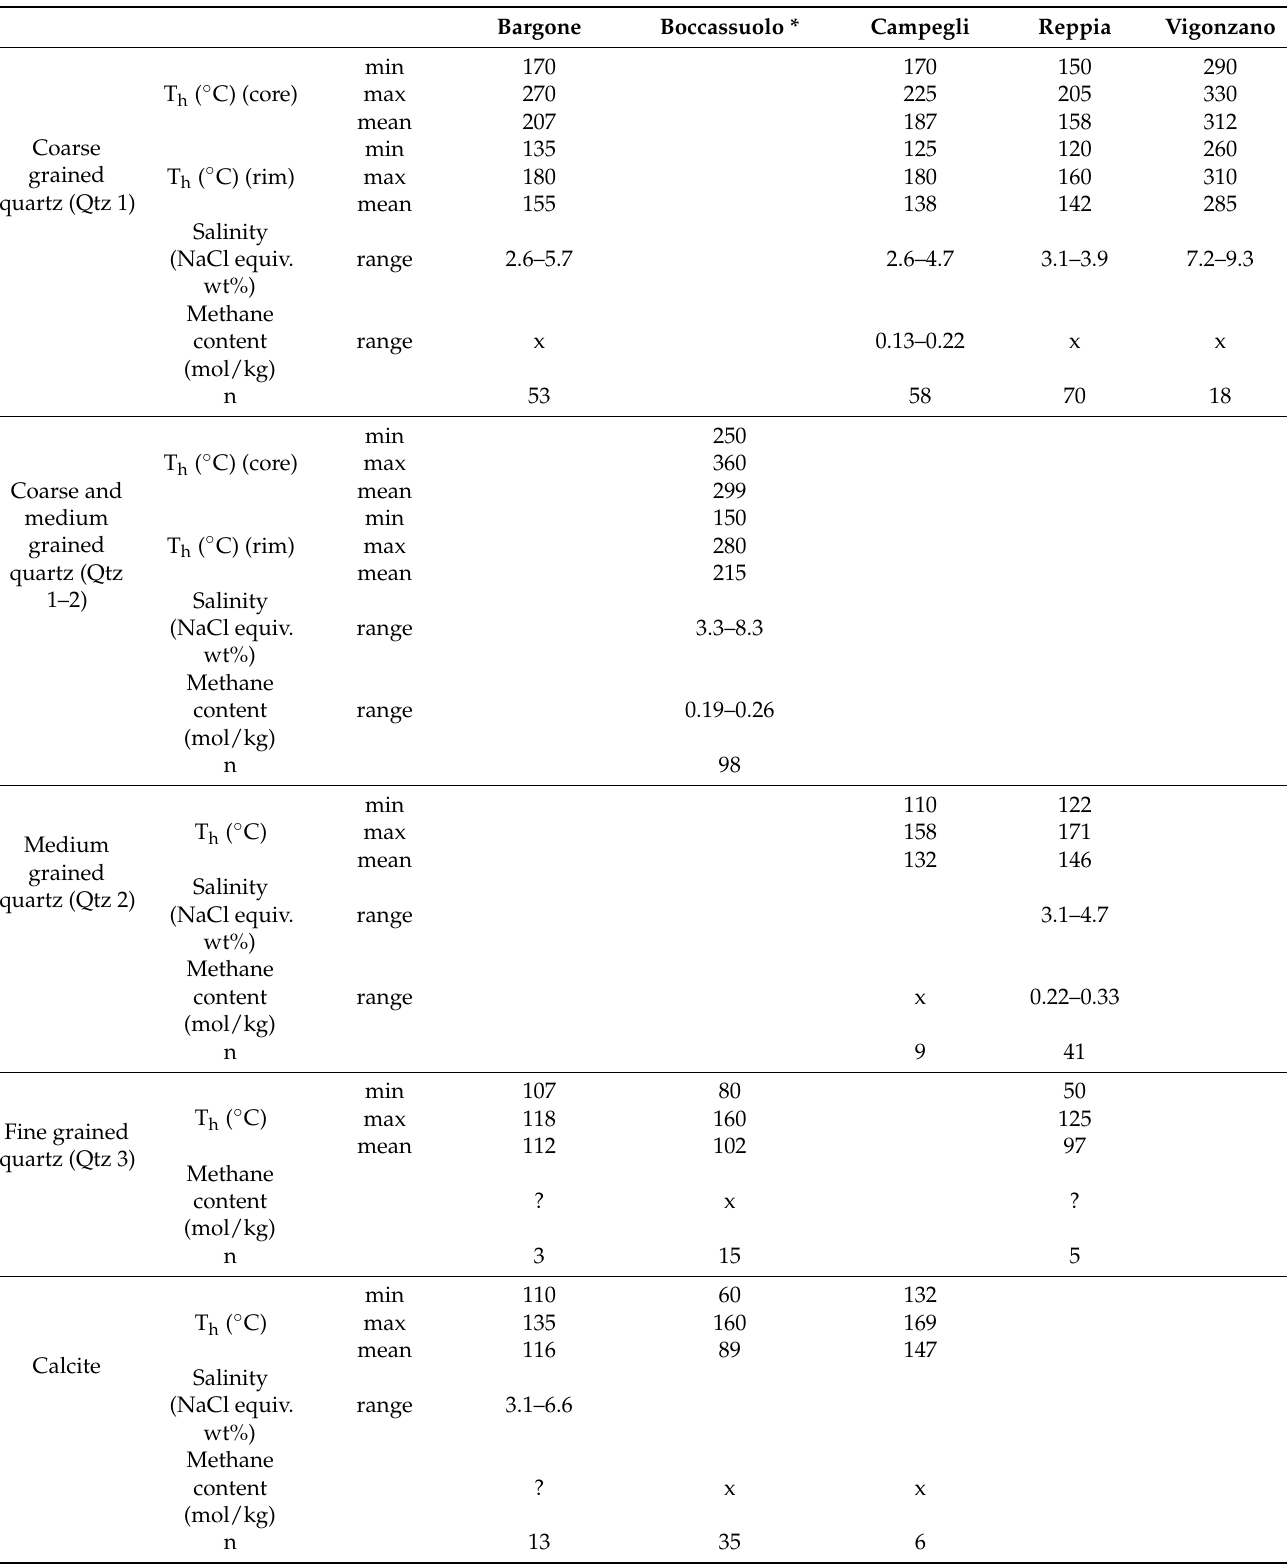
Table A2. Summary of primary fluid inclusion data.